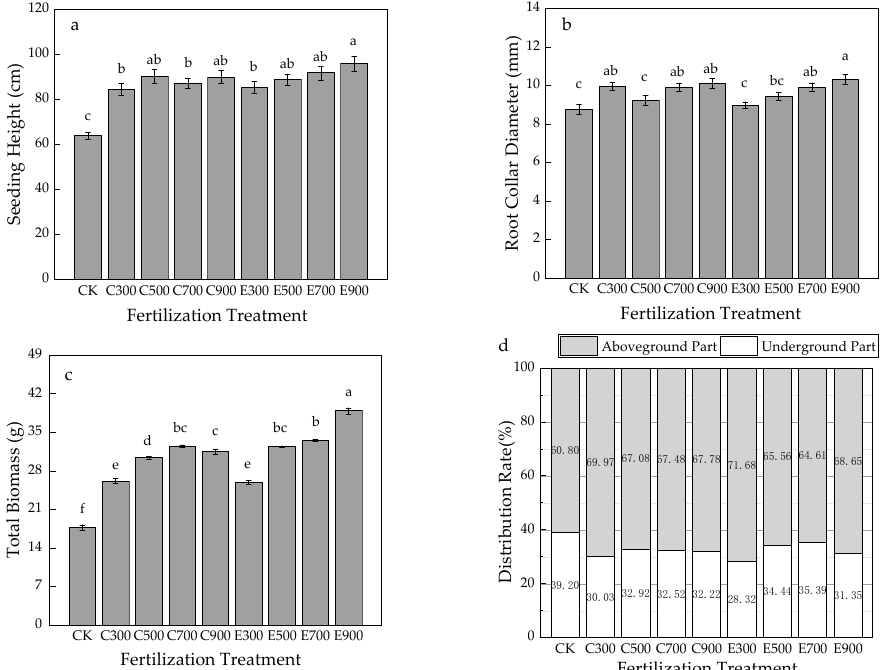
Figure 1. Effects of fertilization on seedling height ( a ), root collar diameter ( b ), total biomass ( c ), and proportion of the plant structure ( d ) of Q. nuttallii container seedlings. Lowercase letters represent significance at 0.05 level and the same letter indicates no significant difference in full text.